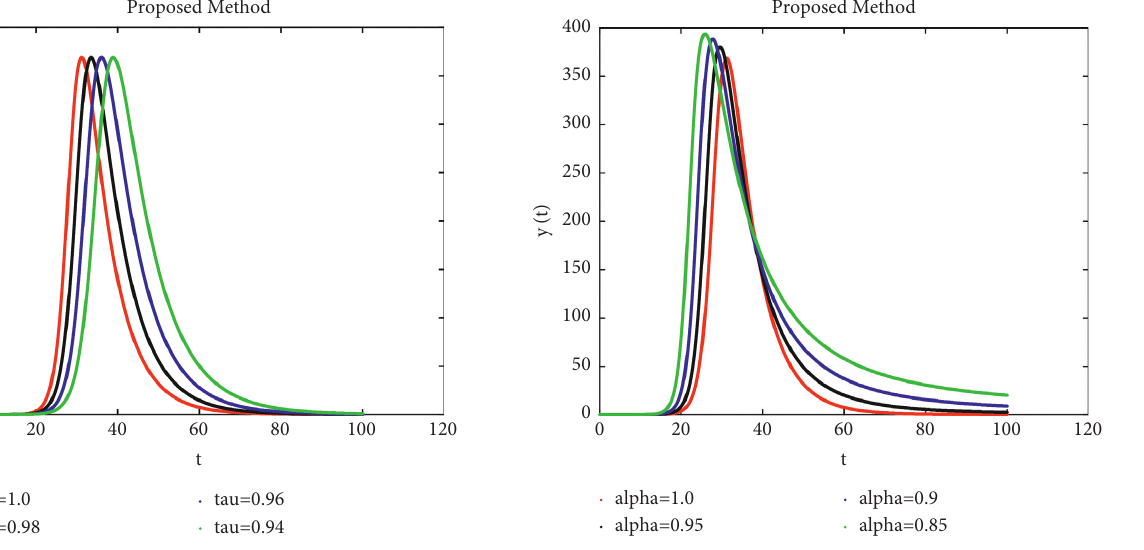
Figure 13: Dynamical behavior of infected cells at α � 1 and various fractal order under Mittag-Leffler kernel.